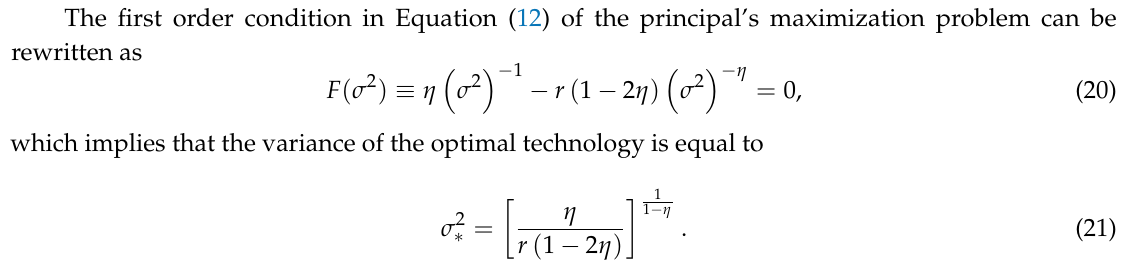
Table 93: Inequalities AMS Inequalities AMS